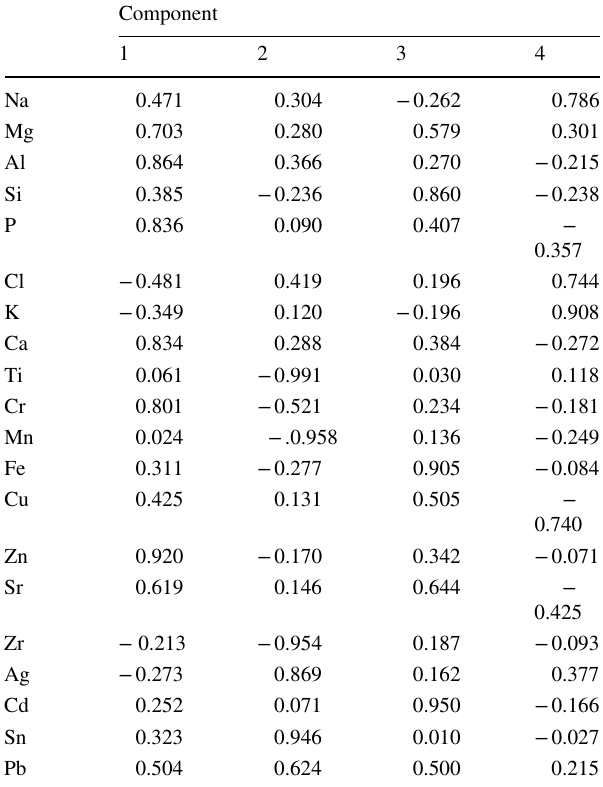
Fig. 2 Component plot in rotated space of the elemental concentra- tion Table 5 Rotated component matrix of the elemental concentration